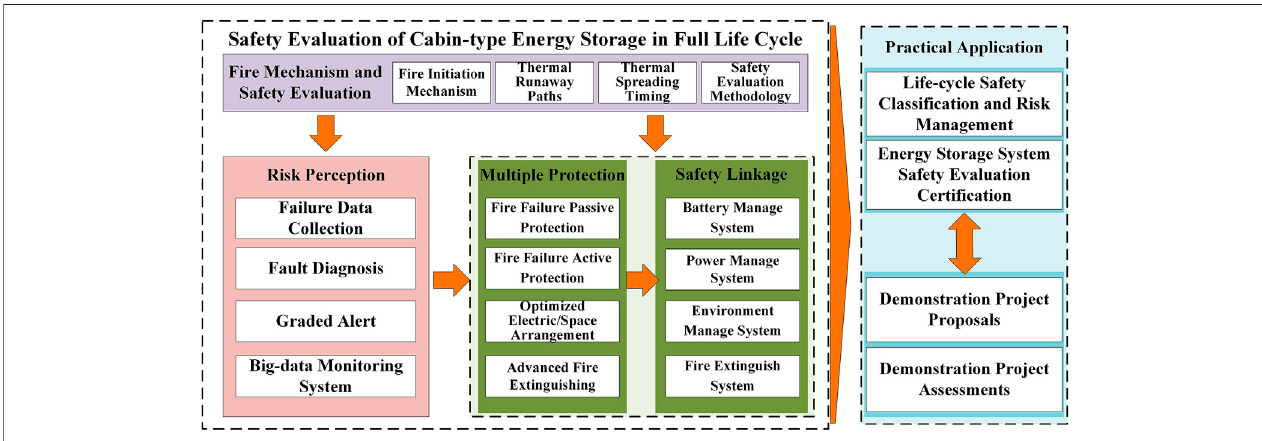
FIGURE 4 | Technical roadmap for the modularized